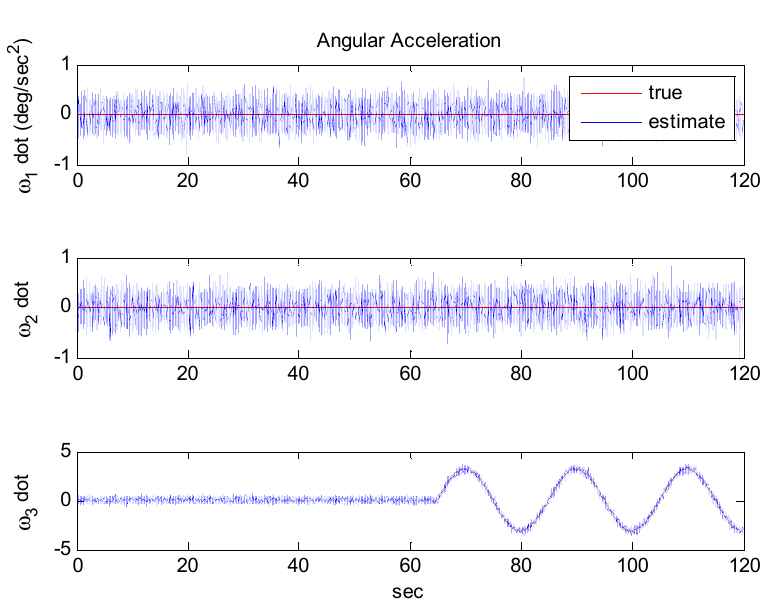
Figure 10. Angular acceleration: Case